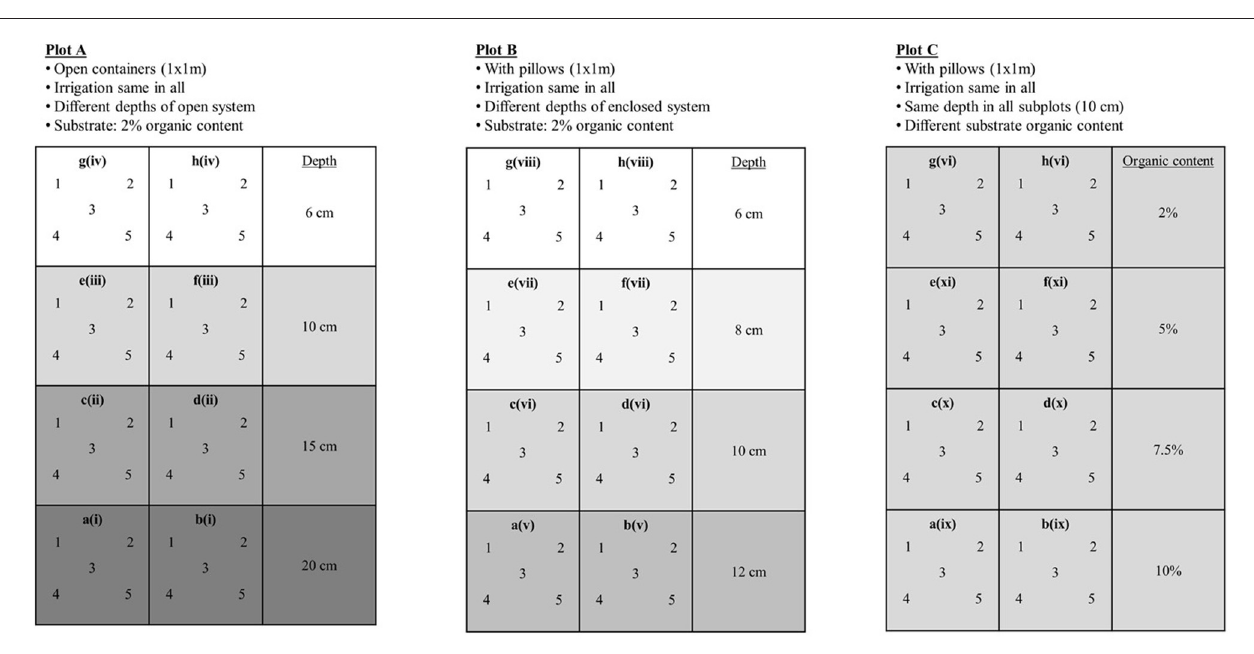
FIGURE 1 | The experimental site location and movement of the sun. Source: Google maps and www.gaisma.com.